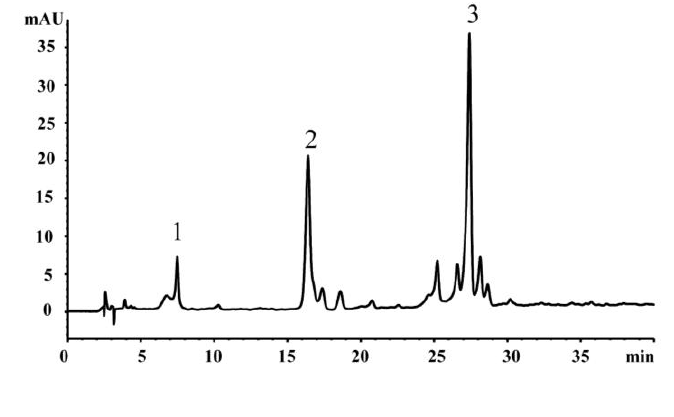
Figure 1. Chromatographic profile of ethanol extract of Hedyotis diffusa Willd (EEHDW). In order to control the quality of EEHDW, the peak areas of 1, 2, 3 should be in the optimum ratio of 1:6.4:9.2. An Agilent 1200 series HPLC system with DAD detector and a Sepax Sapphire-C column was used. The mobile phase consisted of solvent A (methanol) 18 and solvent B (water). The gradient procedure was used as follows: 20–30% A at 0–15 min and 40–60% A at 15–40 min. The flow rate was 1.0 mL/min and the column